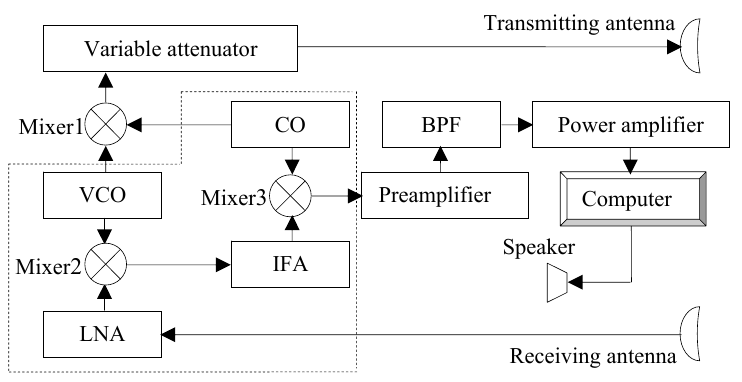
Figure 1. Block diagram of the radar speech